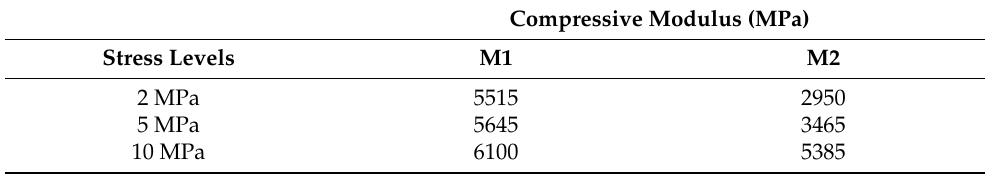
Table 4. Compressive moduli of M1 and M2 materials determined for different stress levels.